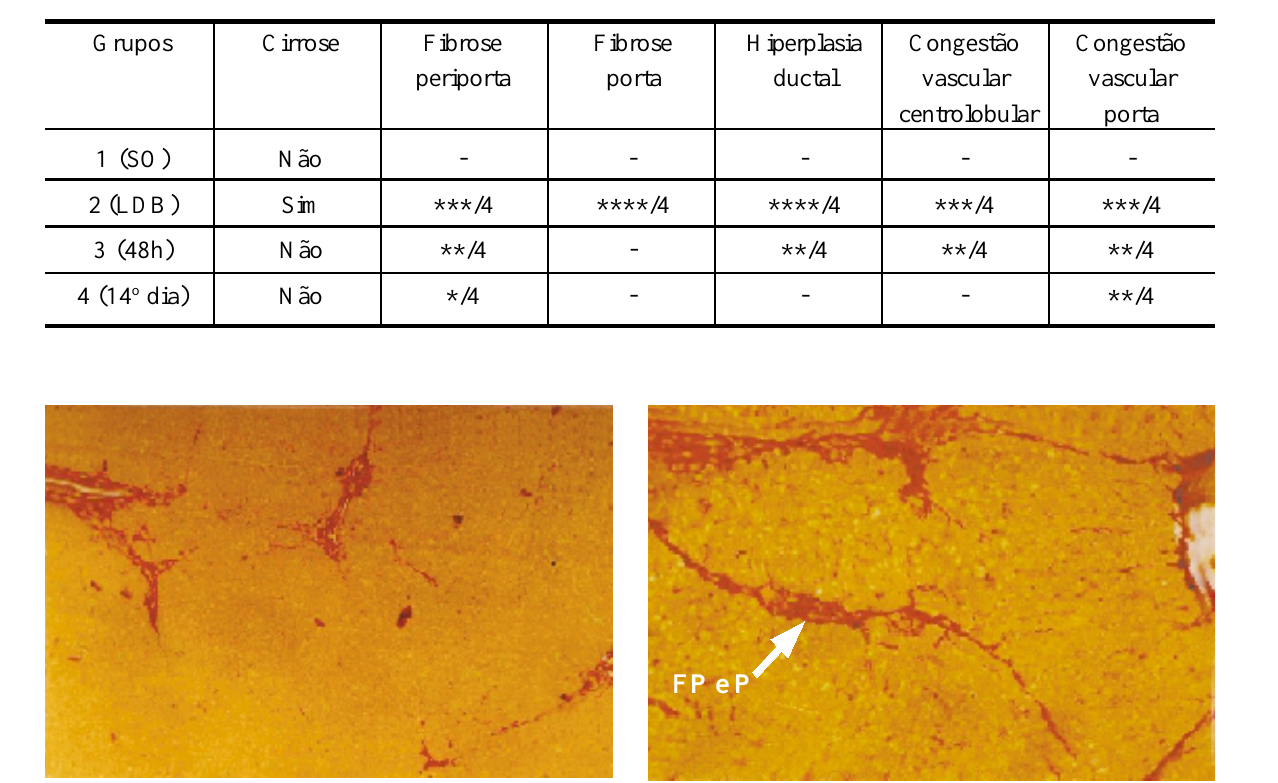
FIGURA 9 - Fotografia apresentando o preparado histológico do grupo 2 (cirróticos), com coloração Picrosírius, 100x. (FP= fibrose periporta e P= porta).